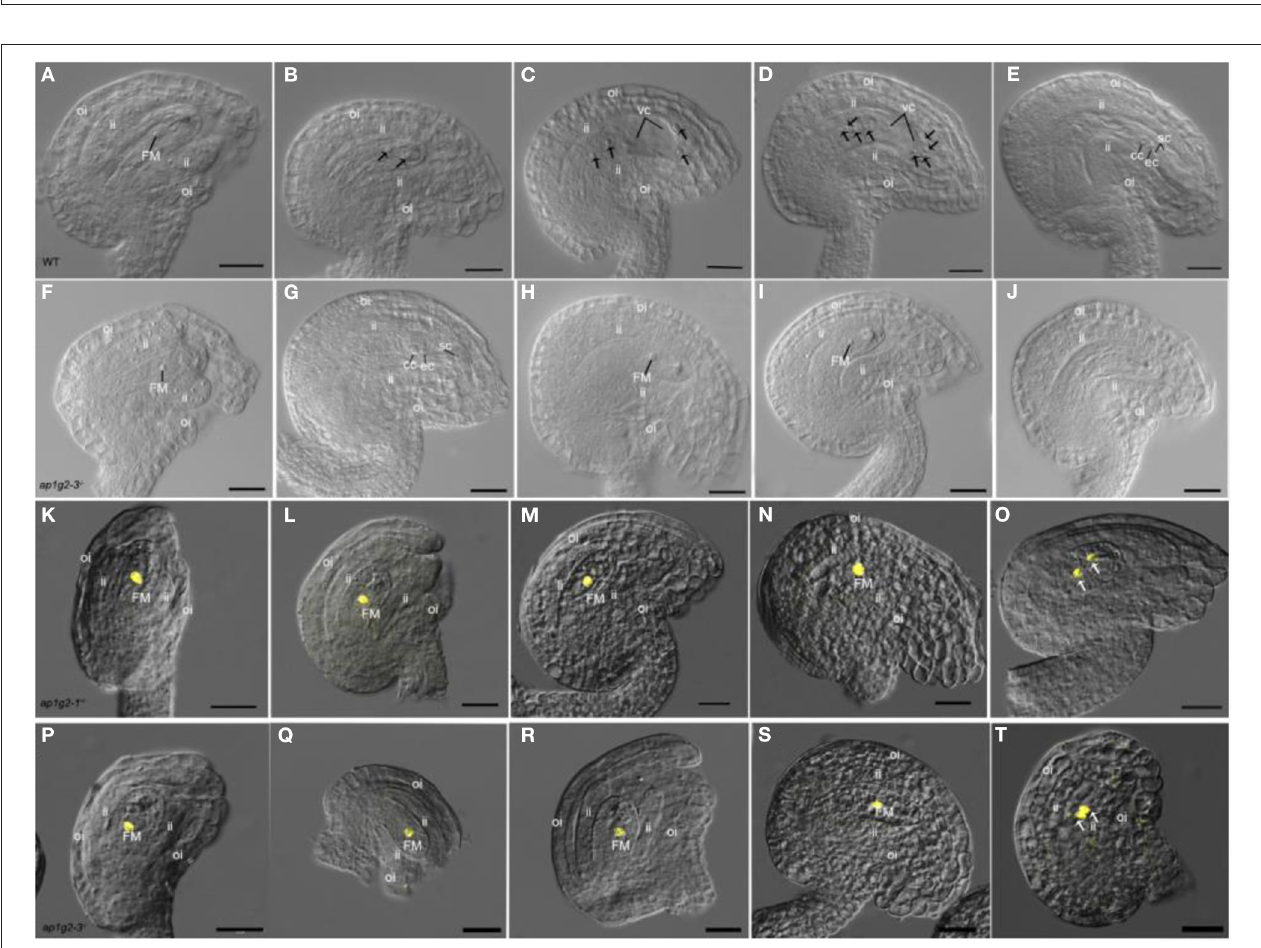
FIGURE 2 | Female gametogenesis is impaired in ovules from ap1g2-1 + / − and ap1g2-3 − / − plants. (A–E) Ovule development in the wild-type, Stage FG1 (A) ; Stage FG3 (B) ; Stage FG4 (C) ; Stage FG5 (D) ; Stage FG7 (E) . (F–J) Ovules in ap1g2-3 − / − , a normal ovule at Stage FG1 (F) ; a mautrue ovule at FG7 aborted ovules arrested at FG1 (H,I) ; (J) Aborted ovules without functional megaspore degenerated. (K–O) Analysis of H2B-YFP expression under the control of the AKV promoter in ap1g2-1 + / − . (L–N) Aborted ovules arrested at FG1 in ap1g2-1 + / − . (O) YFP signals in the wild-type ovule at the FG2 stage. (P–T) Analysis of H2B-YFP expression under the control of the AKV promoter in ap1g2-3 − / − . (Q–S) Aborted ovules arrested at FG1 in ap1g2-1 + / − . (T) The wild-type ovule at the FG2 stage. A scale bar = 20 µ m, ii, inner integuments; oi, outer integuments; FM, functional megaspore; cc, central cell; ec, egg cell; sc, synergid